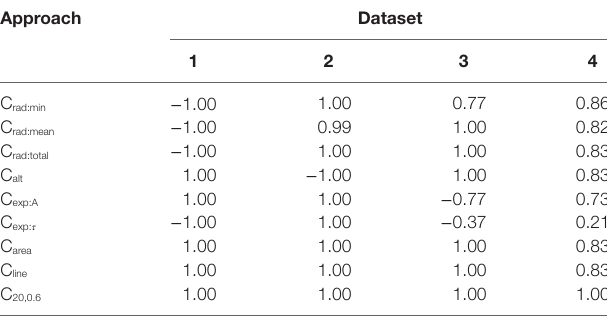
tABLe 2 | Spearman’s rank correlation between the convexity measures obtained via the different quantification approaches and the parameter varied for each data set.